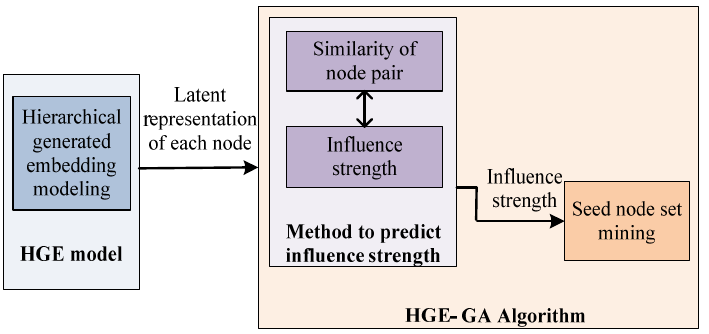
Figure 3. Overview of the system